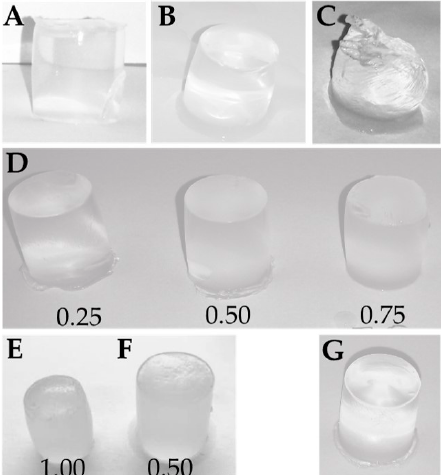
Figure 2. Ca-saturated alginate hydrogels (1.0% w / v ). ( A ): POA (P 0 = 0.02), ( B ): POA (P 0 = 0.04), ( C ): POA (P 0 = 0.08), ( D ): Mixed hydrogels of POA (P 0 = 0.08) and stipe alginate in fractions of W POA = 0.25, 0.50 and 0.75. ( E ): Epim POA-MeOTyr solely, ( F ): Mixed hydrogels of Epim POA-MeOTyr and stipe alginate (W POA* = 0.50). ( G ): Hydrogels of solely stipe alginate. Abbreviations: POA: Partially periodate oxidized alginate. P 0 : Fraction of oxidized residues (degree of oxidation). Epim POA-MeOTyr: Mannuronan